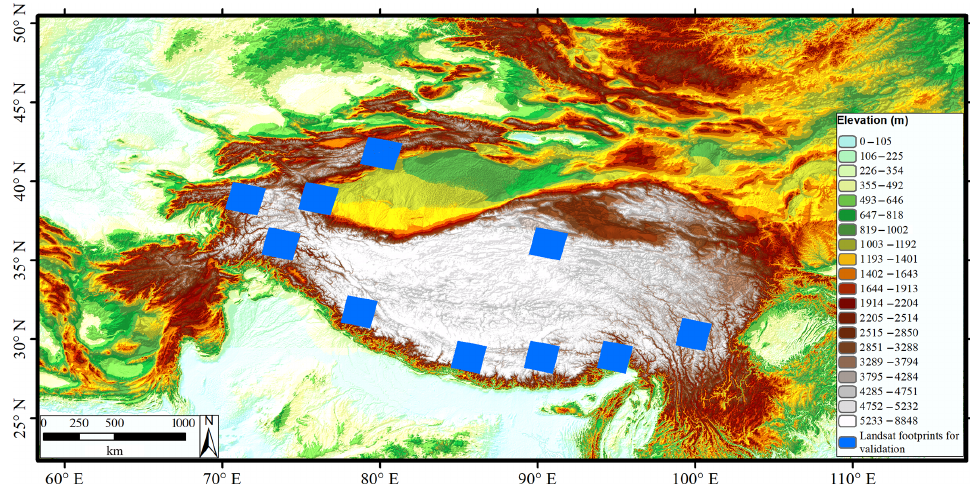
Figure 1. Study area map showing elevation throughout the region and Landsat 8 satellite scenes used for MODIS snow validation. Two images of each Landsat footprint shown in this figure were used for